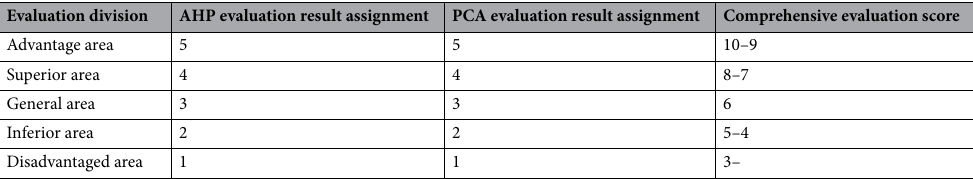
Table 6. Regional evaluation table for comprehensive